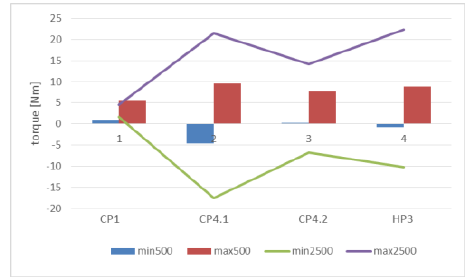
Fig. 10. Minimum and maximum torque at 30 MPa pumping pressure and 500 and 2500 rpm shaft speeds